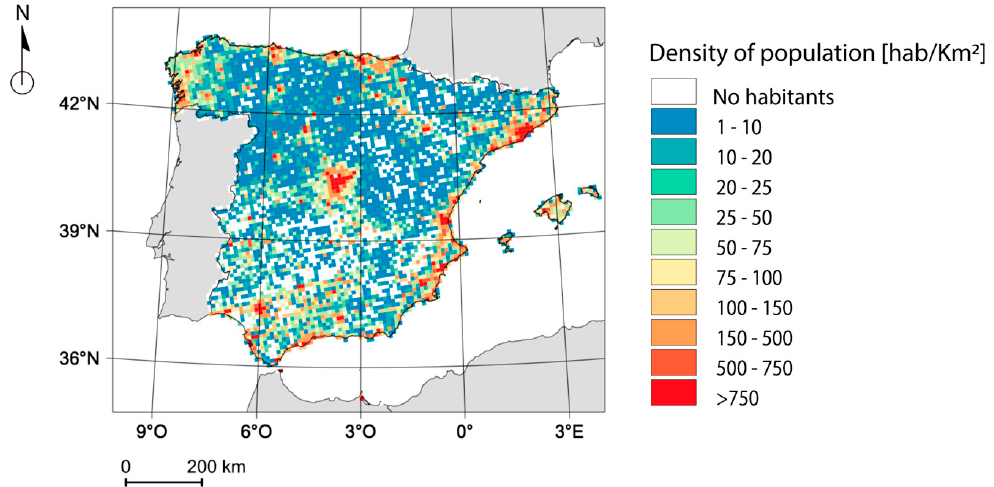
Figure 1. Distribution of population density in Spain on a 10 × 10 km grid.